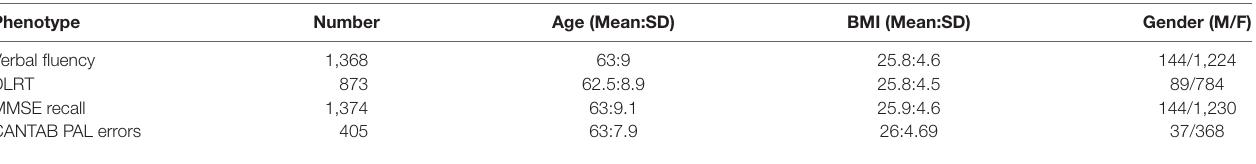
TABLE 1 | Summary of study samples used for four cognitive